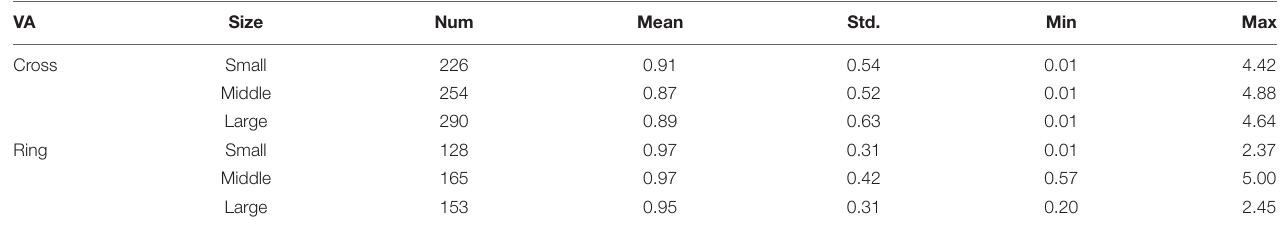
FIGURE 12 | Map of the adjusted successful response time. TABLE 3 | Descriptive statistics of response